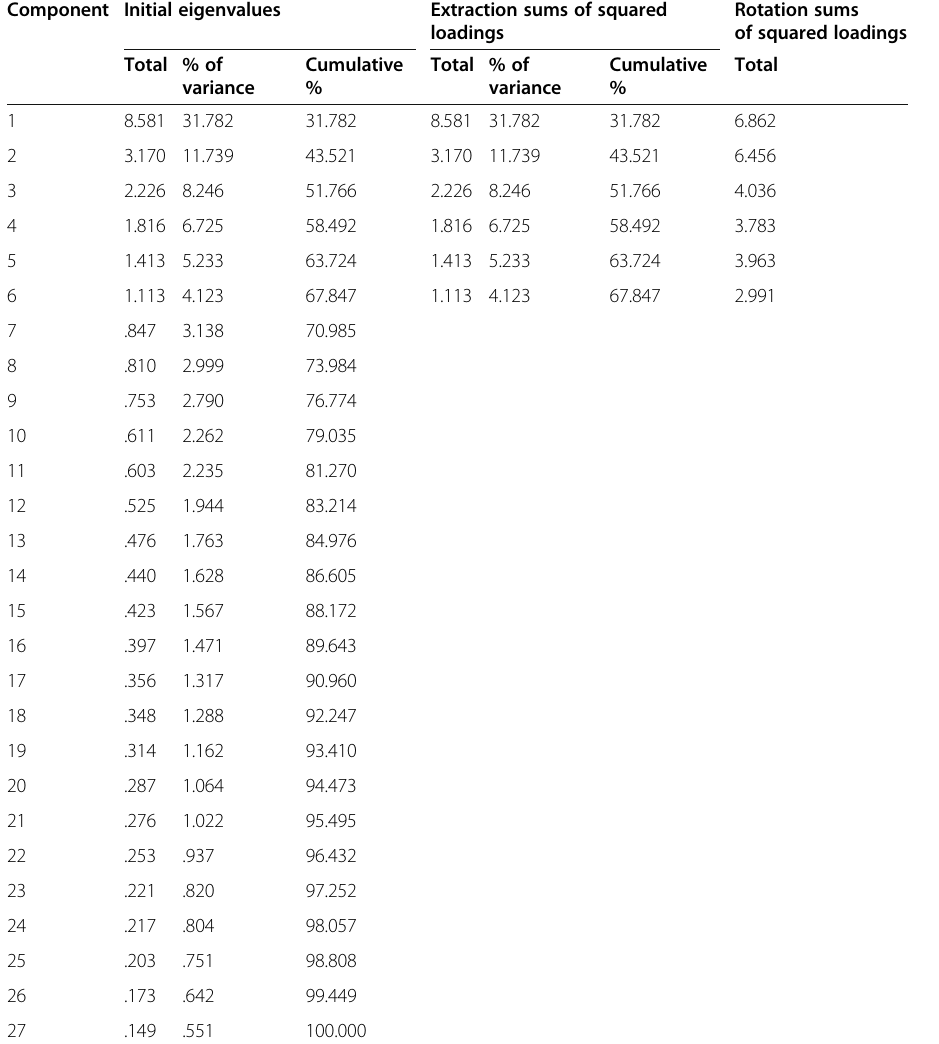
Table 3 Total variance